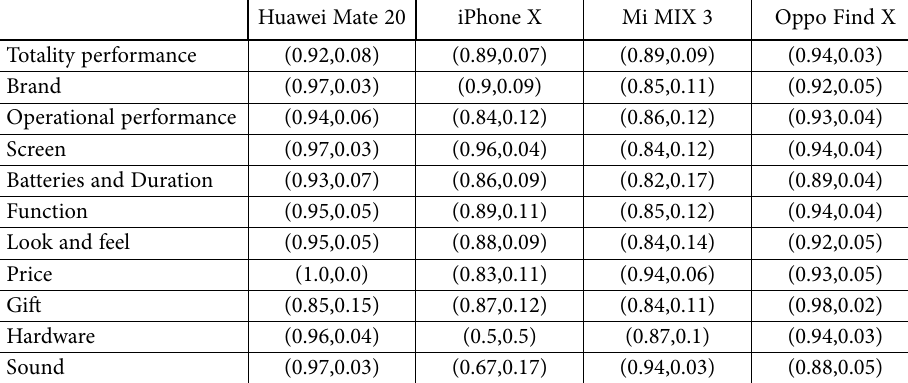
Table 8. The intuitionistic fuzzy decision matrix of